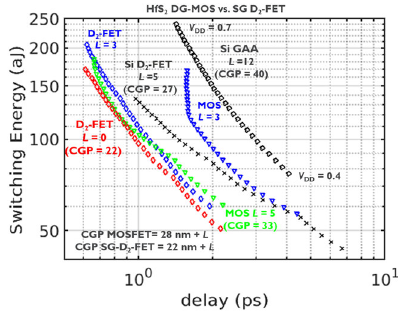
Fig. 14 Maximum achievable I ON vs L for optimized n-type MOSFETs and D 2 -FETs made of Si, WS 2 , and HfS 2 . A DG architecture is assumed for all the 2D MOSFETs. For the Si MOSFETs, a GAA transistor was used. A SG architecture is employed for the 2D D 2 -FETs, whereas a DG transistor is used for the Si-D 2 -FETs. EOT = 0.5 nm. V DD = 0.6 V. I OFF = 10 nA/ μ m. The current is normalized by the gate perimeter. For the D 2 -FETs, we used Δ L = L /2 with a minimum value of Δ L = 4 nm for L ≤ 8 nm.